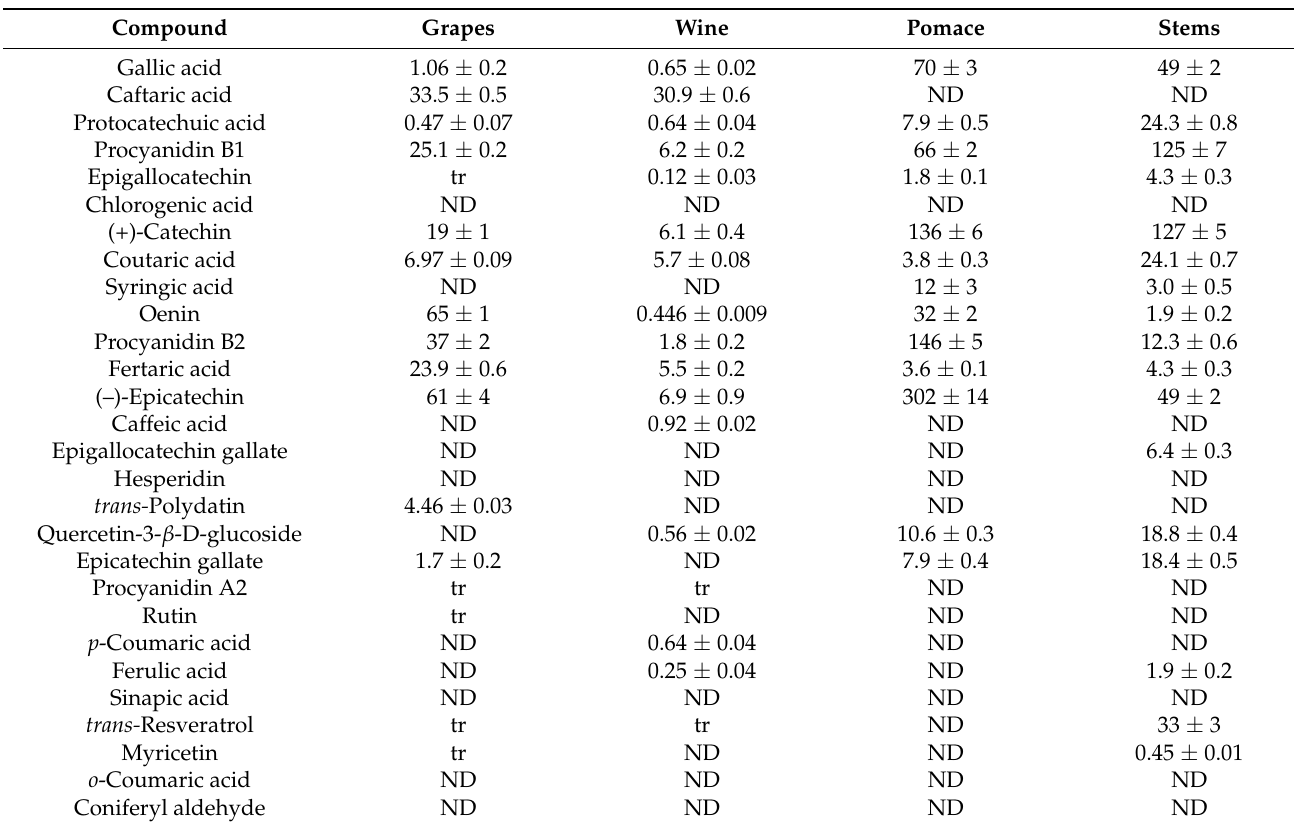
Table 6. Quantitation of phenolic compound content in the Aidani mavro red variety (mg/kg DW) and wine (mg/L).